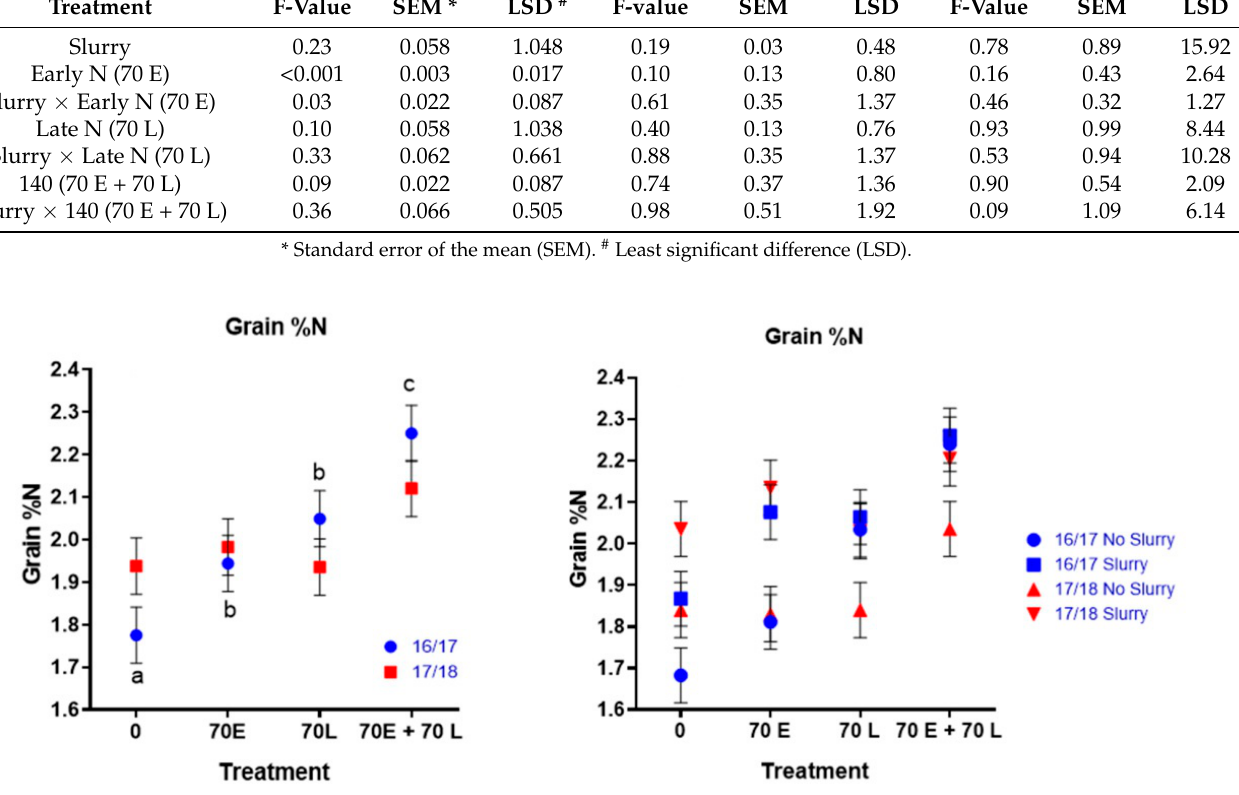
Figure 2. Average grain N percentage from fertiliser rate, timing and application of slurry (%). Error bars represent standard error of the mean (SEM). Different letters denote statistical differences between treatments determined by Fisher’s protected LSD (0.05).